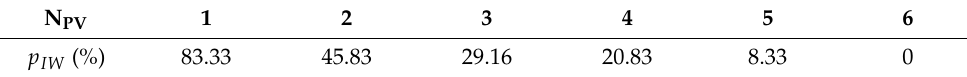
Table 9. Sensitivity to the number of PV arrays in the second scenario.